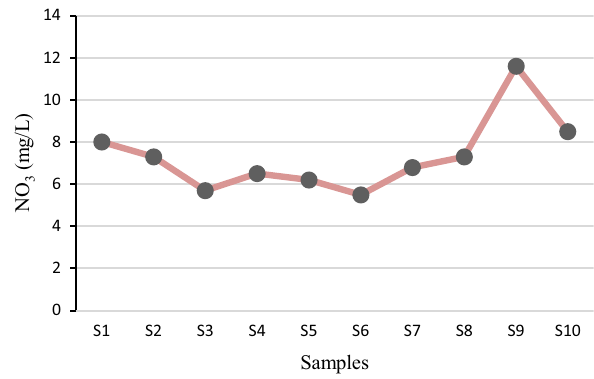
Fig. 8 Nitrate content of analyzed dairy effluents